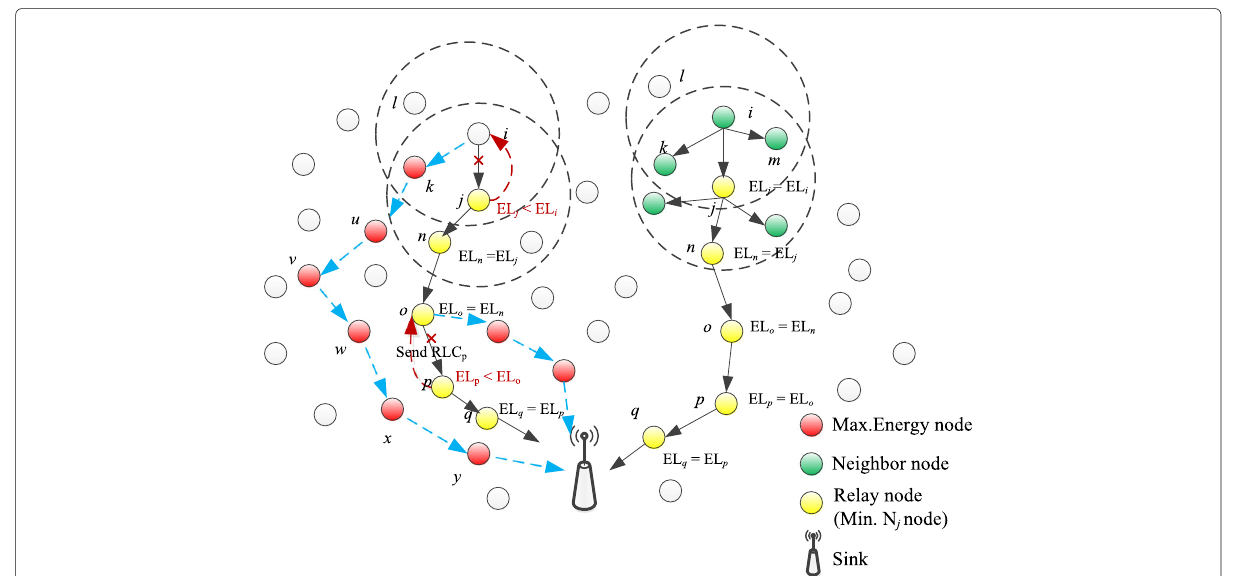
Fig. 6 Data transmission based on EL difference. The link between nodes are dynamic, if EL of successor is lower, the node will find a new relay, and a link become two links by this way